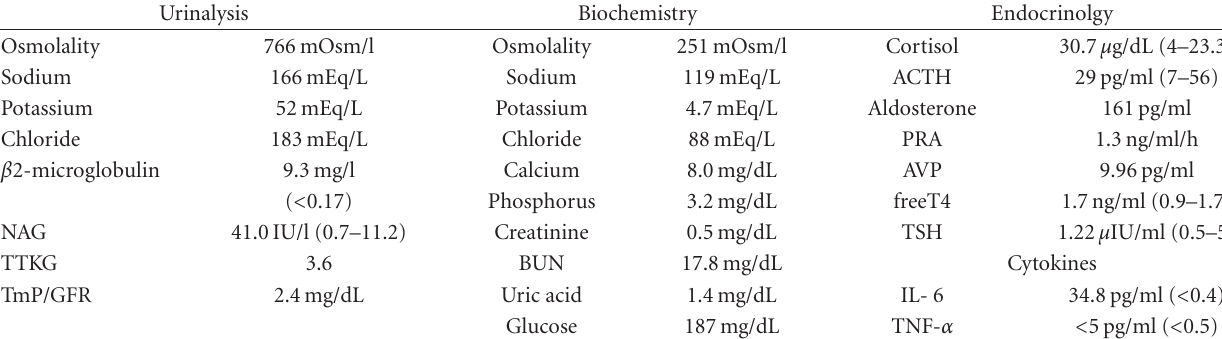
Table 1: Laboratory data on